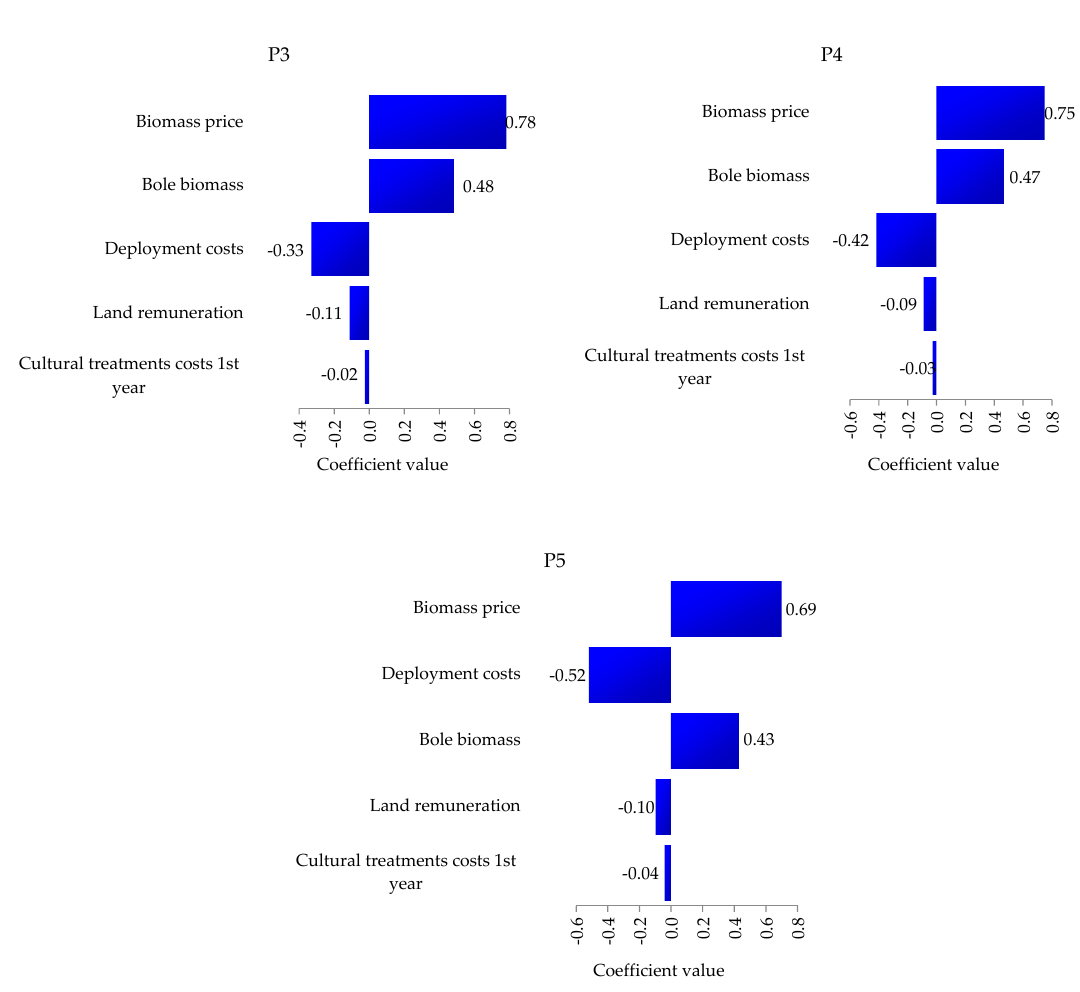
Figure 1. Spearman monotonic correlation coefficients of the five main stochastic variables in relation to net present value ( NPV ) of the investment projects in eucalypt forest stands for biomass production.